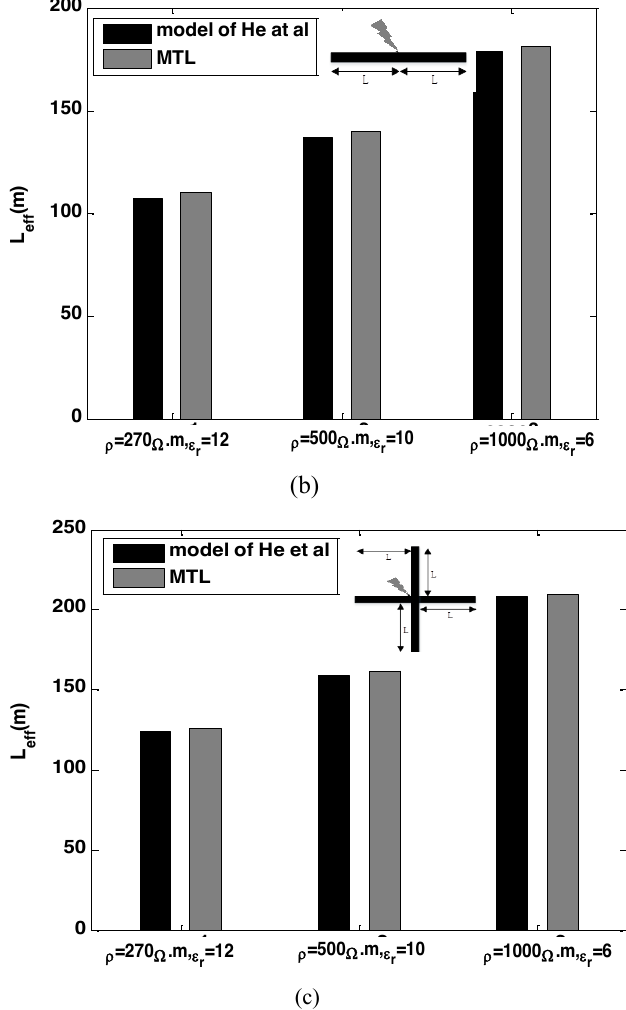
Figure 9: Comparison of effective lengths for (a): corner-fed electrode, (b): center-fed electrode with two arms, and (c): center-fed electrode with four arms.